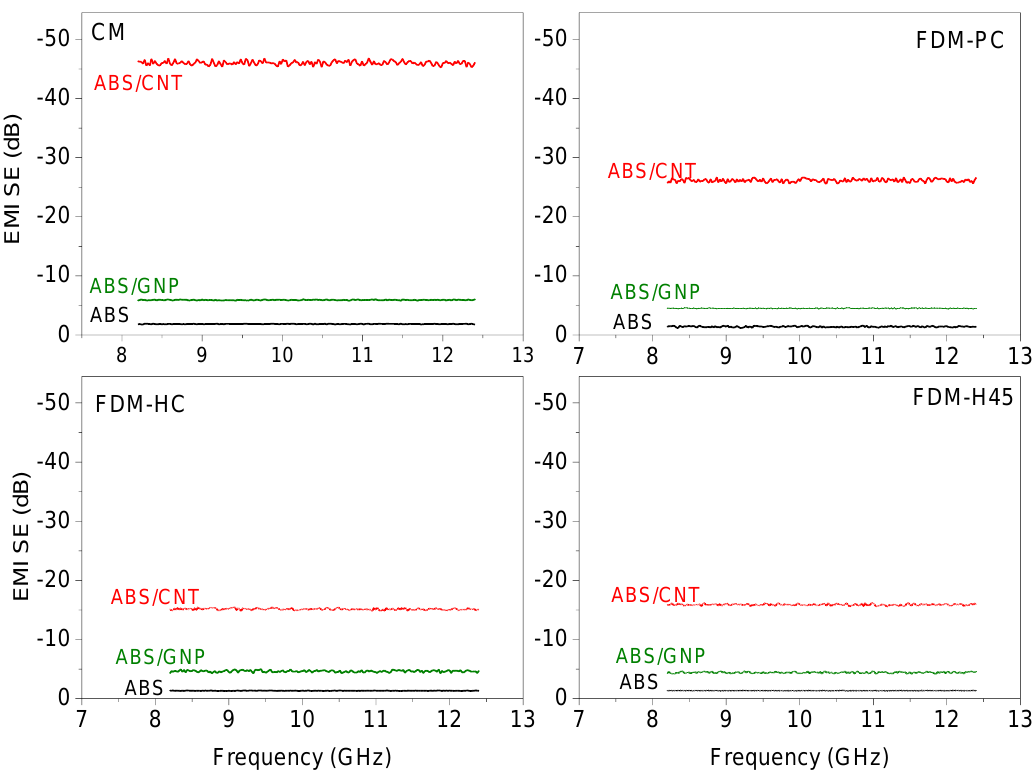
Figure 10. Total EMI shielding effectiveness of ABS and composites: Compression molded ( upper left graph ), FDM-PC ( upper right graph ), FDM-HC ( lower left graph ) and FDM-H45 ( lower right graph ). The orientations PC, HC and H45 are described in Figure 2.